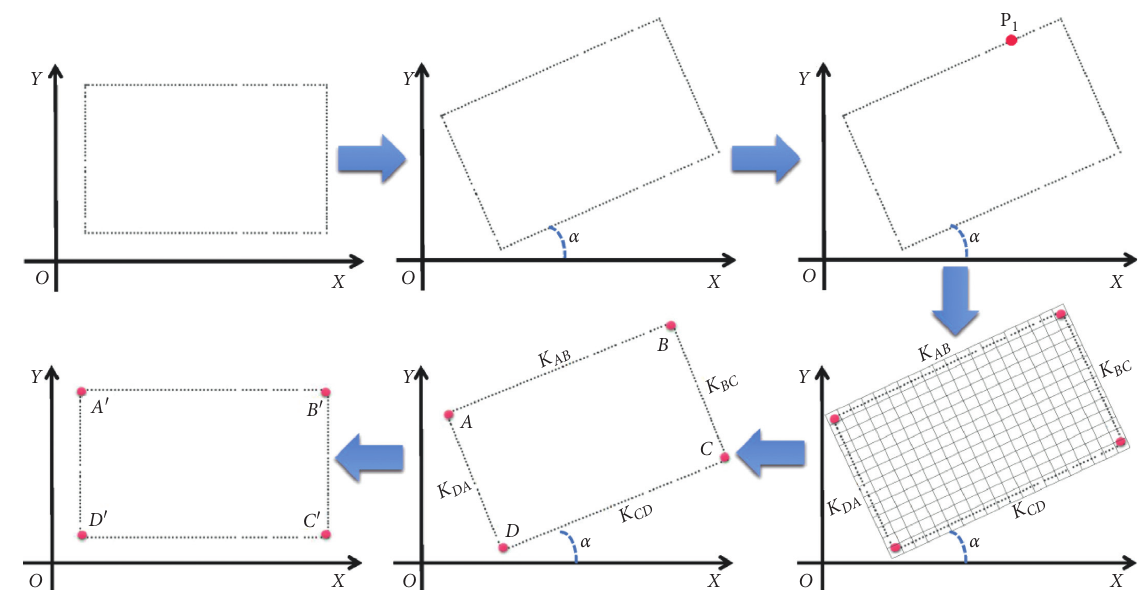
Figure 12: Schematic of the corner coordinate solution of the bent cap point cloud